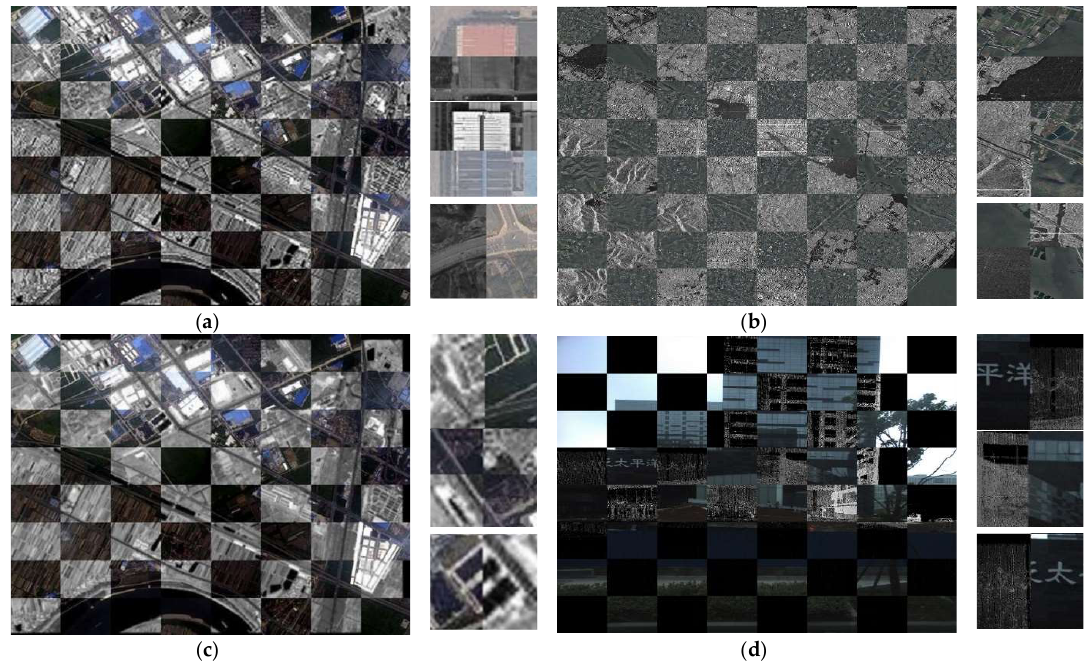
Figure 5. Checkerboard visualization for the qualitative evaluation of the polynomial registration model based on manually selection: ( a ) Mid-infrared image and visible orthomosaic image; ( b ) Terra SAR image and optical image; ( c ) Worldview-3 near infrared image and multispectral image; ( d ) Monolithic cloud point depth image and visible image.